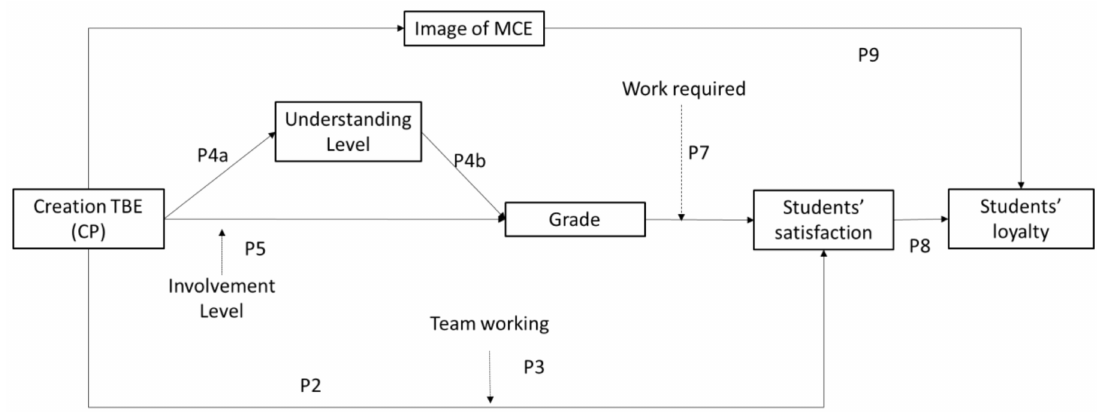
Figure 1. Proposed theoretical